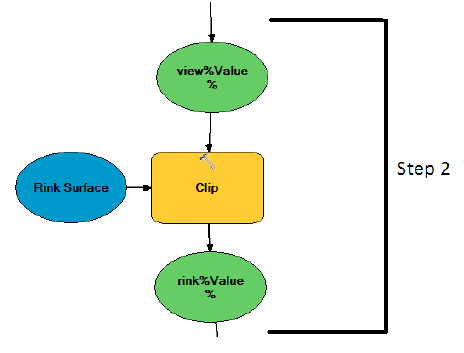
Figure 3: Step 2: clip rink surface